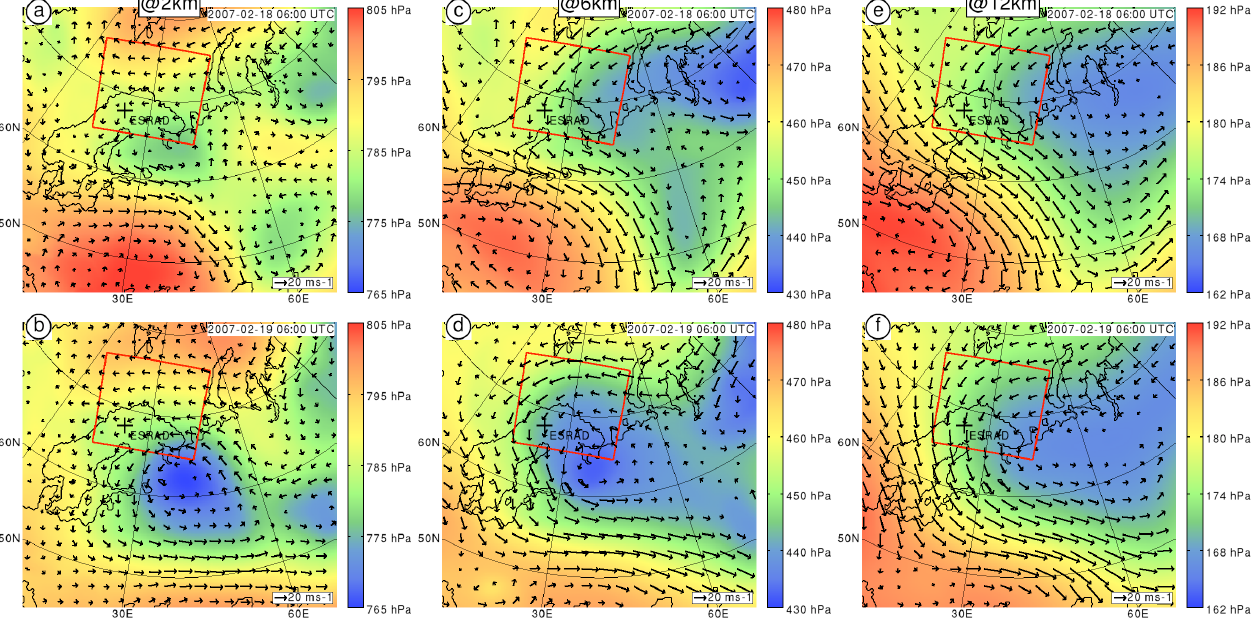
Fig. 1. (a) , (b) Horizontal cross sections at 2km altitude of pressure (colour) in hPa and horizontal winds (arrows) in ms − 1 at 06:00UTC on 18 February 2007 and at 06:00UTC on 19 February 2007, computed with ECMWF analyses. The pressure scale is given by the coloured bar to the right, and the wind scale by the arrow at the bottom right corner of each panel. The red box gives the location of the domain used in the WRF simulation. The black cross gives the location of ESRAD radar. (c) , (d) as in (a) , (b) , except at 6km altitude. (e) , (f) as (a) – (d) , except at 12km altitude.